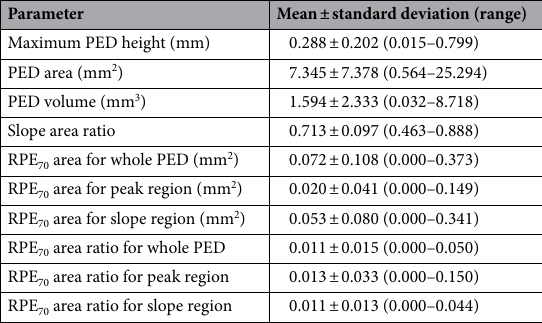
Table 1. Morphometric pigment epithelial detachment parameters, RPE 70 areas, and RPE 70 area ratios. PED pigment epithelial detachment, RPE retinal pigment epithelium.